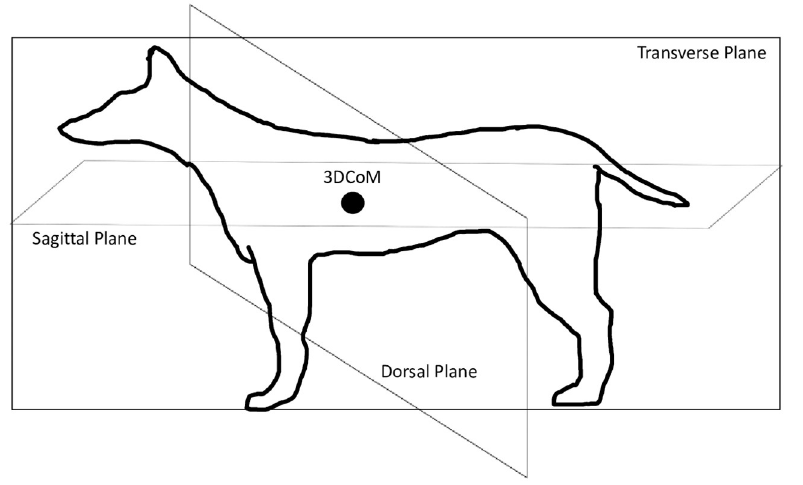
Fig 1. Illustration of the transverse, sagittal and dorsal planes of a dog with a fictitious 3DCoM (black dot).